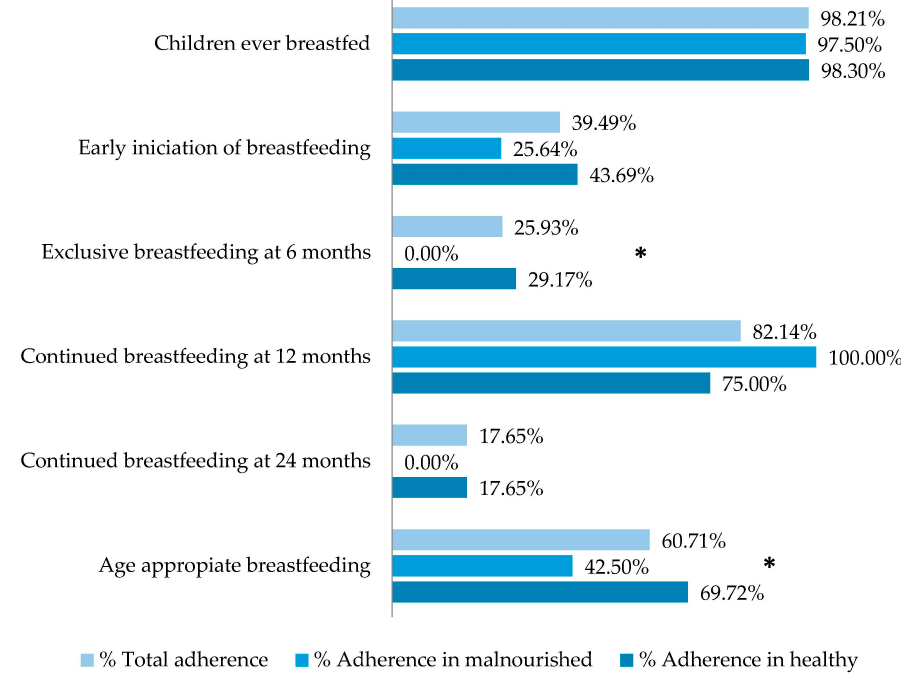
Figure 4. Indicators of breastfeeding practices recommended by WHO in 278 infants seen at the Klinik Saint Espri Health Center, Port au Prince, Haiti (August 2014): Percent adherence in the total group, children with wasting, and healthy children. Footnote: Wasting is defined as W/L < − 2 SD according to the WHO 2006 standard. * p < 0.05, Chi 2 test.